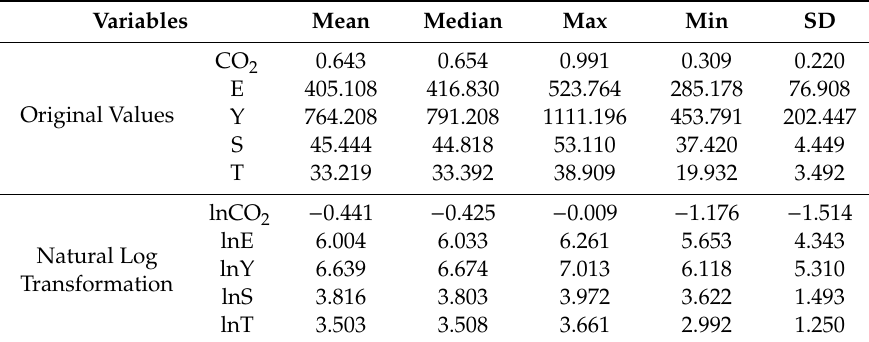
Table 5. Descriptive